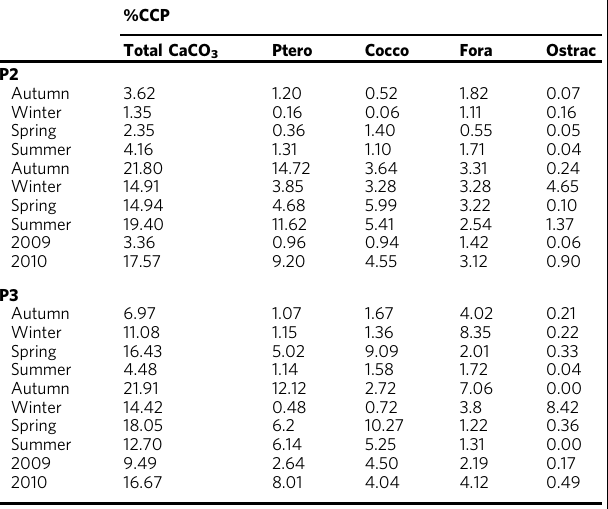
Table 1 Seasonal and annual counter carbonate pump effect (CCP) at sediment traps P2 and